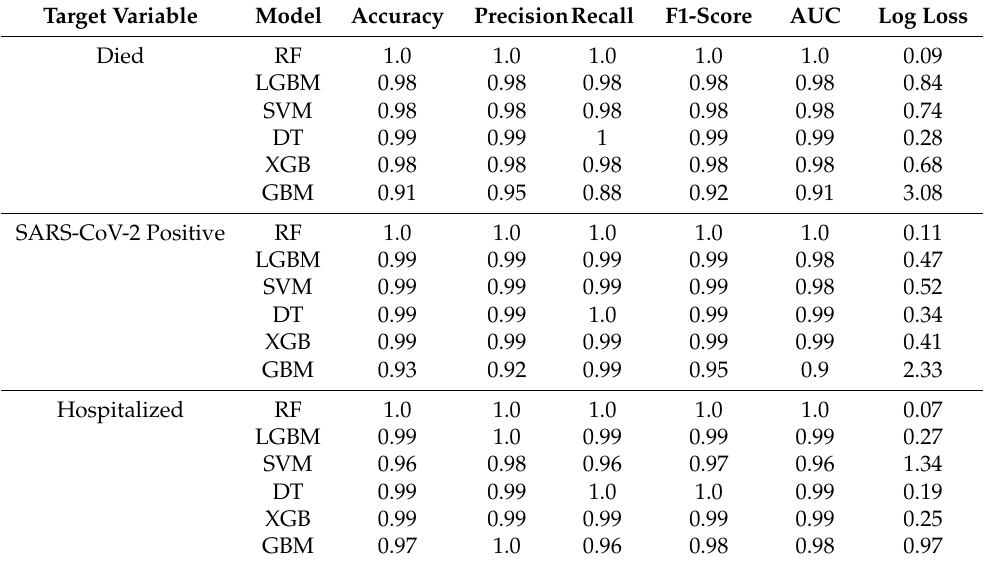
Table 4. Comparative performance evaluation for the patient classification based on machine learning algorithms with the dataset of patients’ adverse reactions after